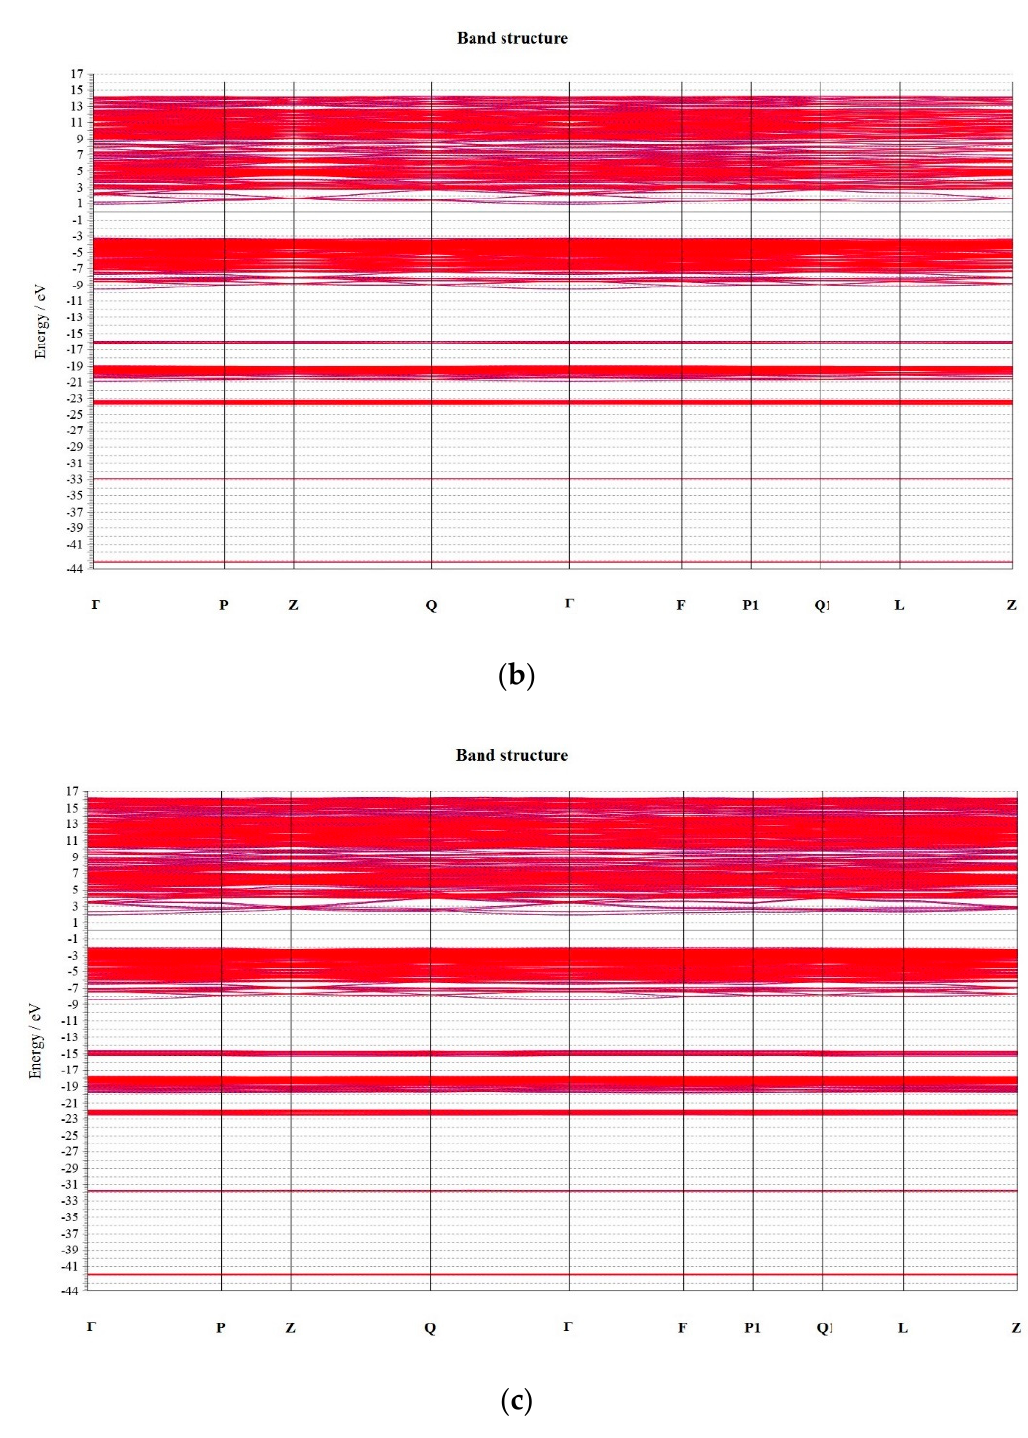
Figure 2. Band structure of the samples ( а ) Y 3 Al 5 O 12 , ( b ) Y 3 Al 5 O 12 :La (2 ions), ( c ) Y 3 Al 5 O 12 :La (4 ions).